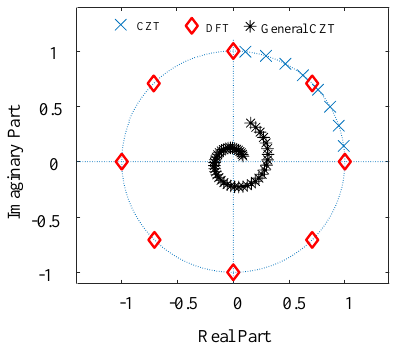
Figure 1. Z-plane comparison of DFT and CZT.